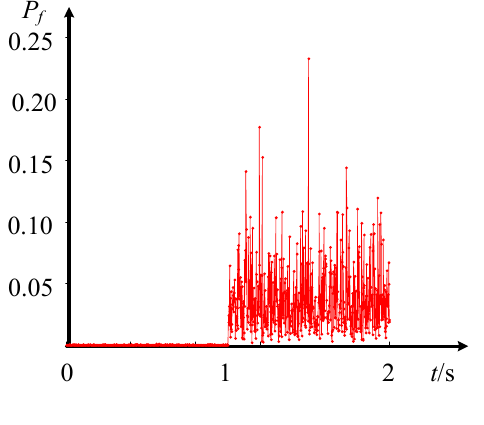
Figure 17. Real time false trip probability for inconsistent delay.